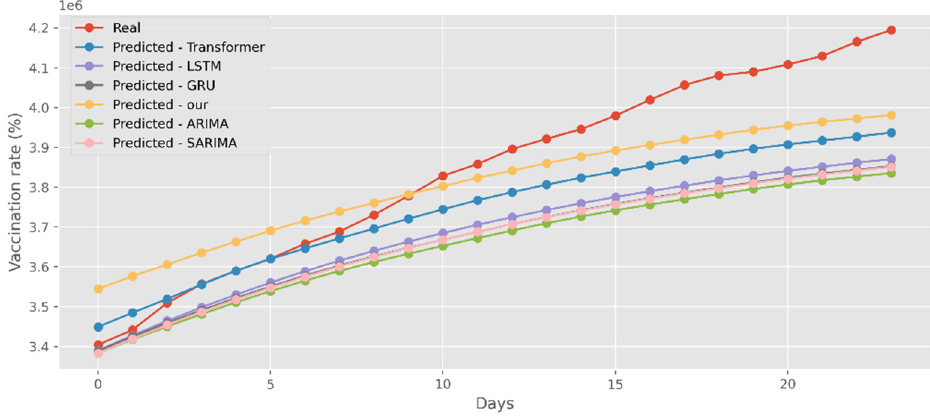
Figure 19. Comparison of COVID ‐ 19 prediction models of vaccinated in NY.